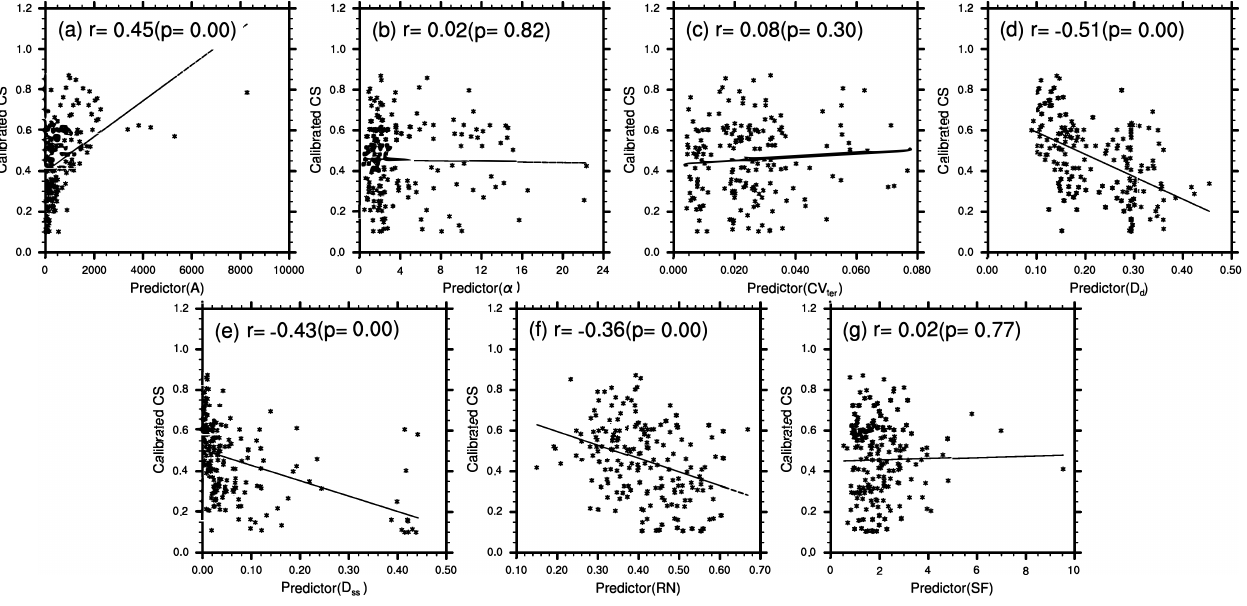
Figure 11. Linear regression between calibrated CS and seven predictors as defined in Table